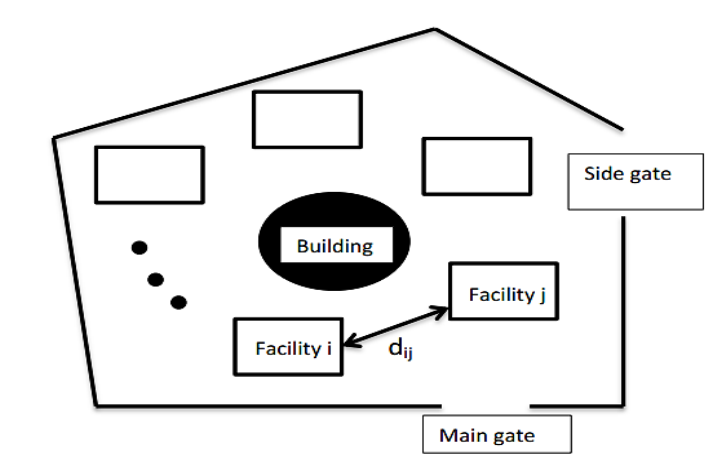
Figure 1. Construction site of the case study mentioned by